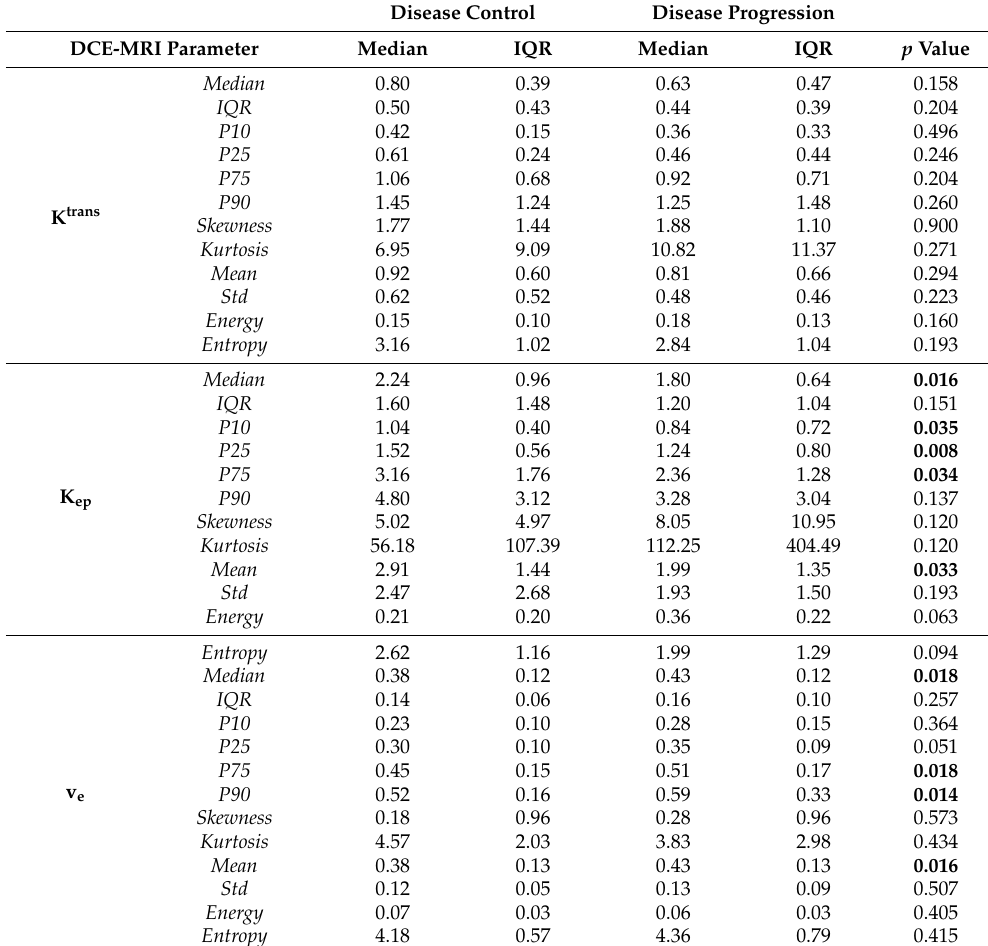
Table 3. Summary statistics of DCE-MRI parameters in the primary tumor (T) for patients with and without disease